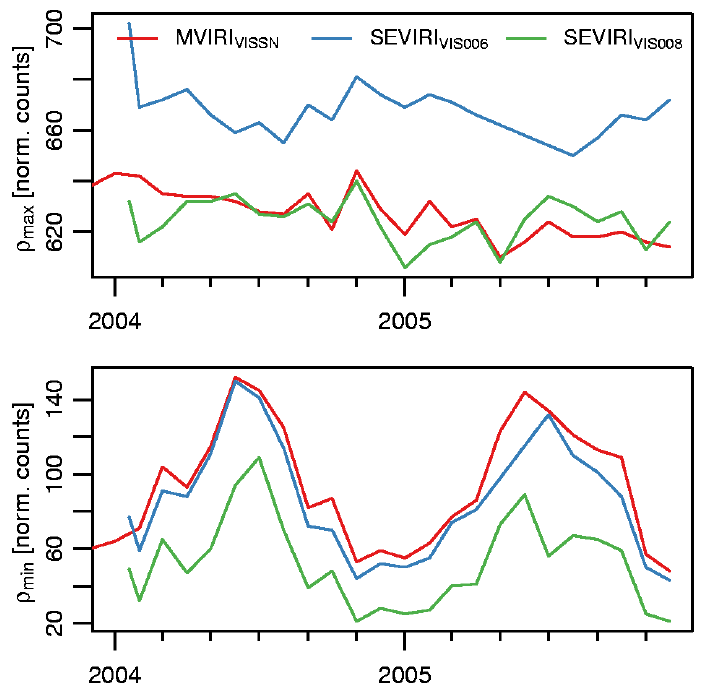
and ρ ( ρ ) for MVIRI and SEVIRI visible channels. max cs max